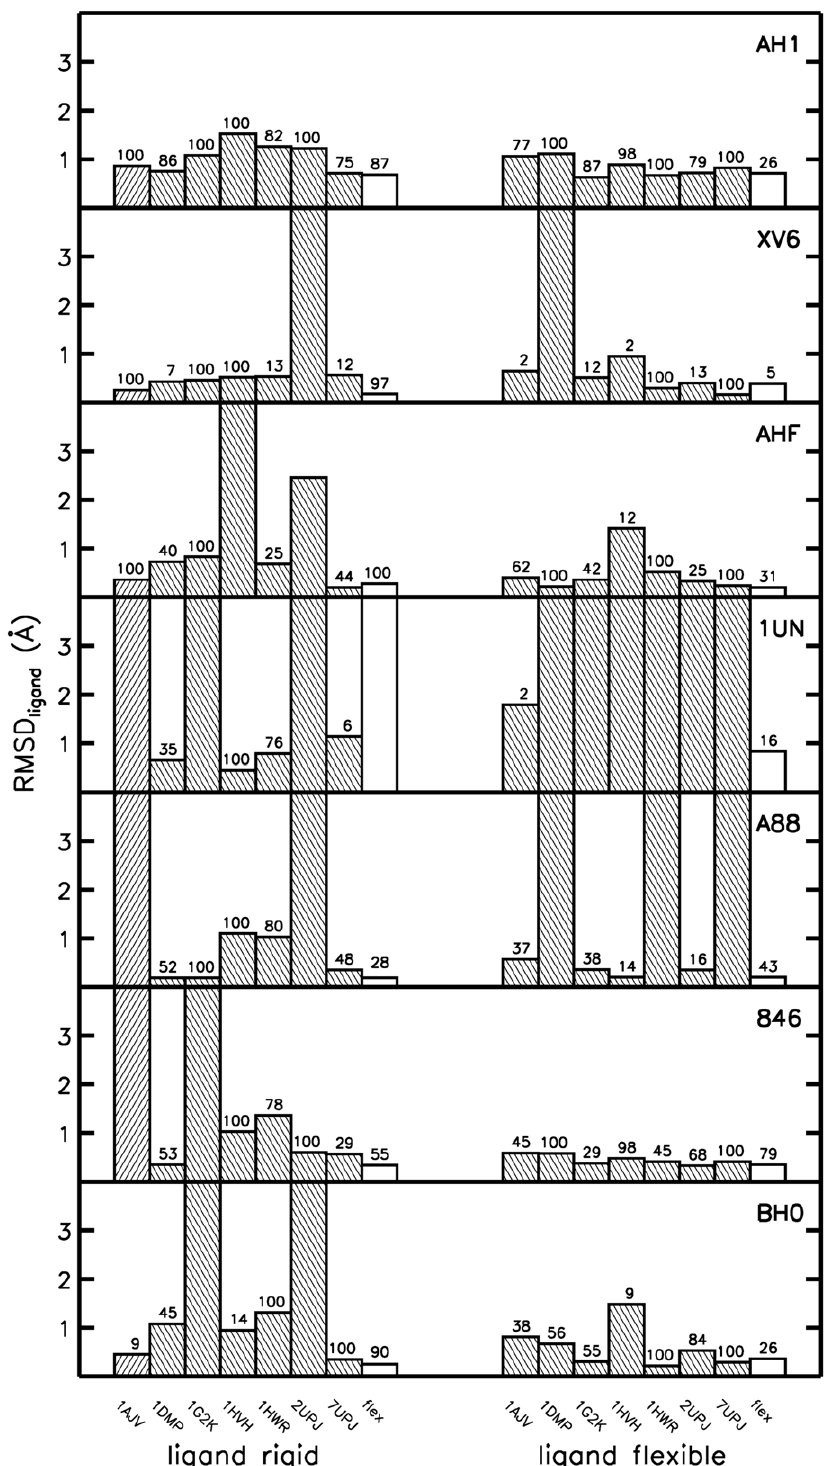
Figure 3. True binder test-set docking results of cross docking, rigid, and flexible receptor docking. Docking results in terms of deviation of the dockedligandfromthenativeplacementfortherigidreceptorcrossdocking,apodocking,andflexiblereceptordockingoftheHIV-1proteasetruebindertestset. Bar height indicates the best RMSD solution found in 100 separate dockings (values are cut at 4A˚). Narrow shaded bars are the dockings of the ligand denoted in the upper right corner of each plot into the rigid receptor structure as indicated in the bottom. Wide shaded bars show the results of the rigid receptor apo docking, non-shaded bars for the flexible receptor docking. Numbers on top of bars indicate the number of dockings per 100 separate docking runs that yield ligand RMSD values below 2A˚. Holo docking results (docking the ligand back to the receptor structure from which it was extracted) are shown as filled bars.